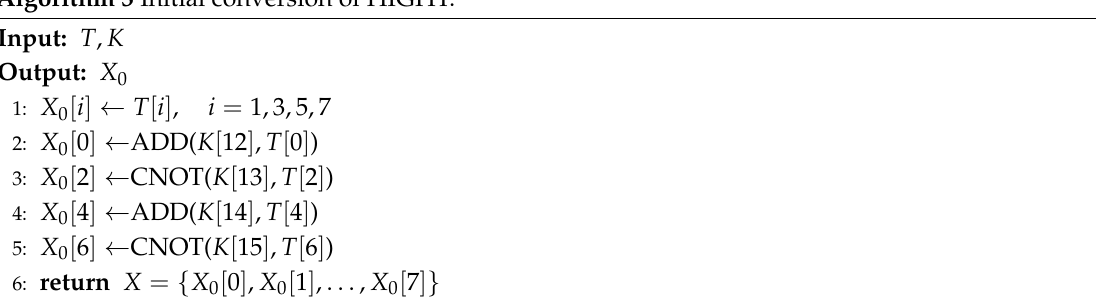
Algorithm 3 Initial conversion of HIGHT.